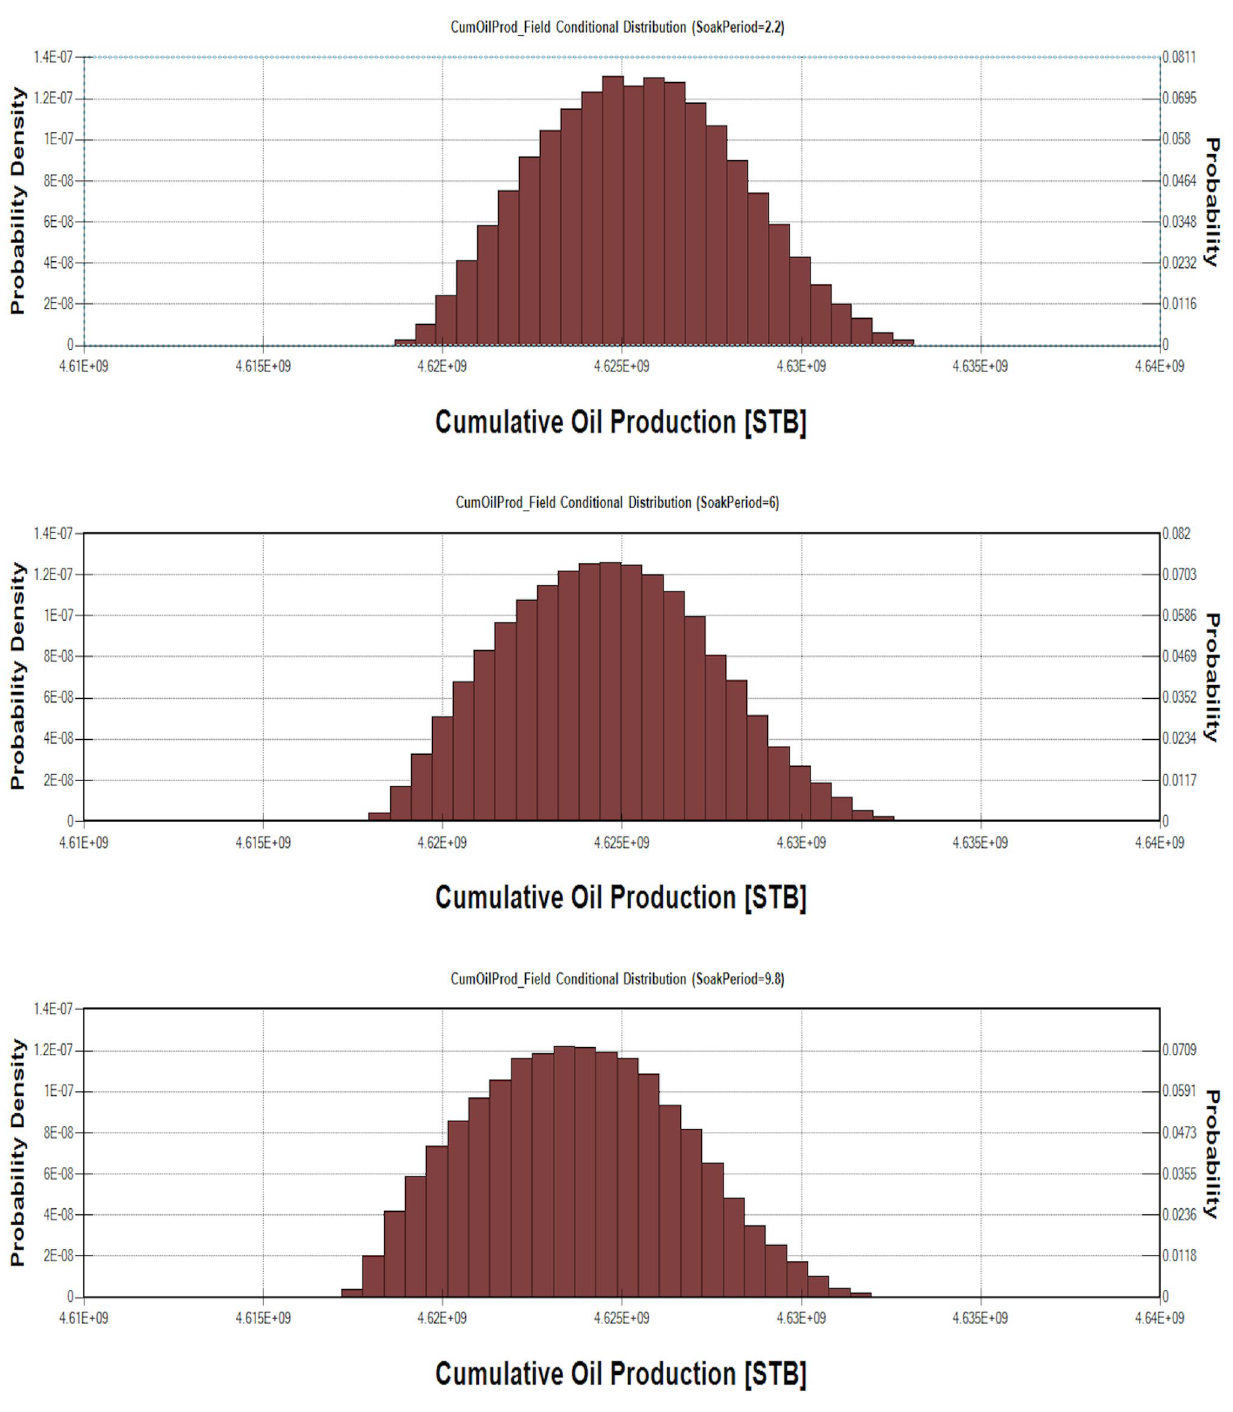
Fig. 20 Probability distribution of flow response as a function of soaking